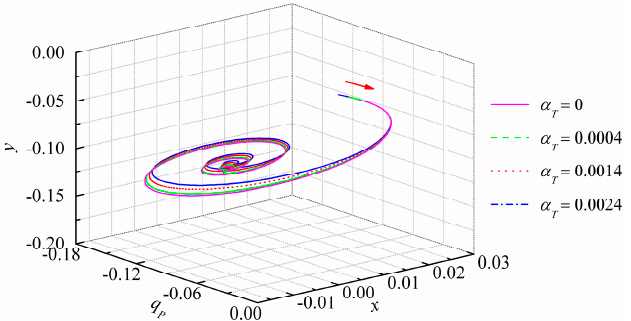
Figure 5. Effect of the throttling orifice head loss coefficient, α T (s 2 /m 5 ), on the dynamic behavior of the hydro-turbine governing system with an air cushion surge chamber [57].